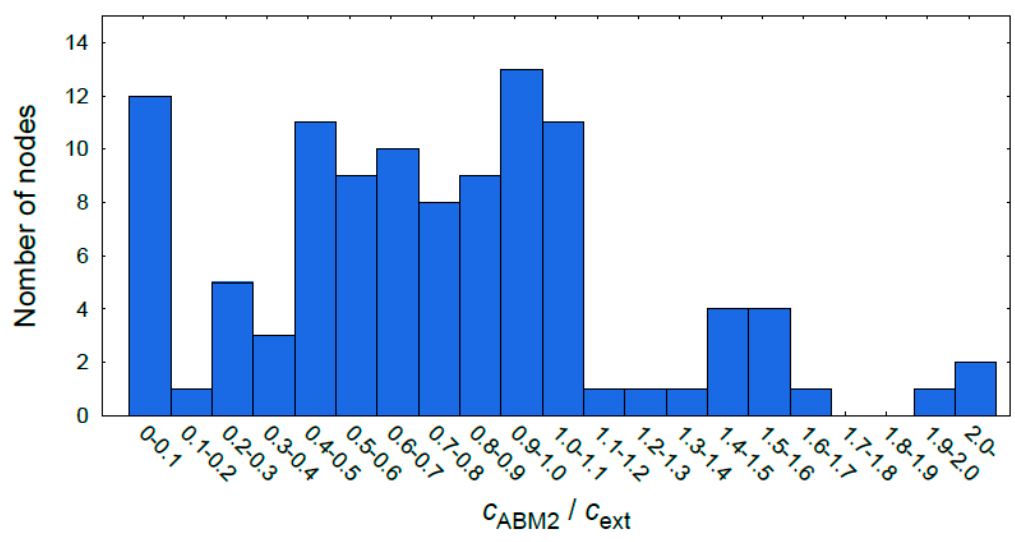
Figure 8. Histogram of nodes as a function of ratio for number of agent visits in Figure 7 to that of rickshaw visits in Figure 5. A total of 86 nodes were visited by rickshaw recorded and used here.